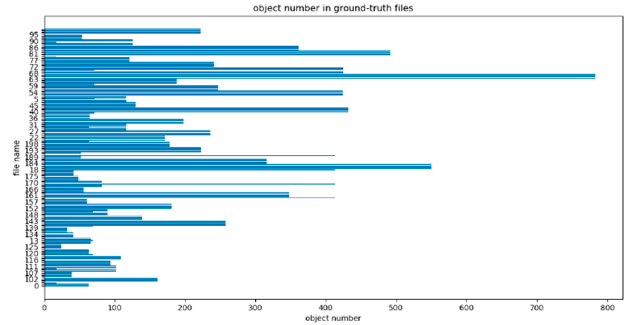
Figure 9. Quantity analysis chart of test picture electronic